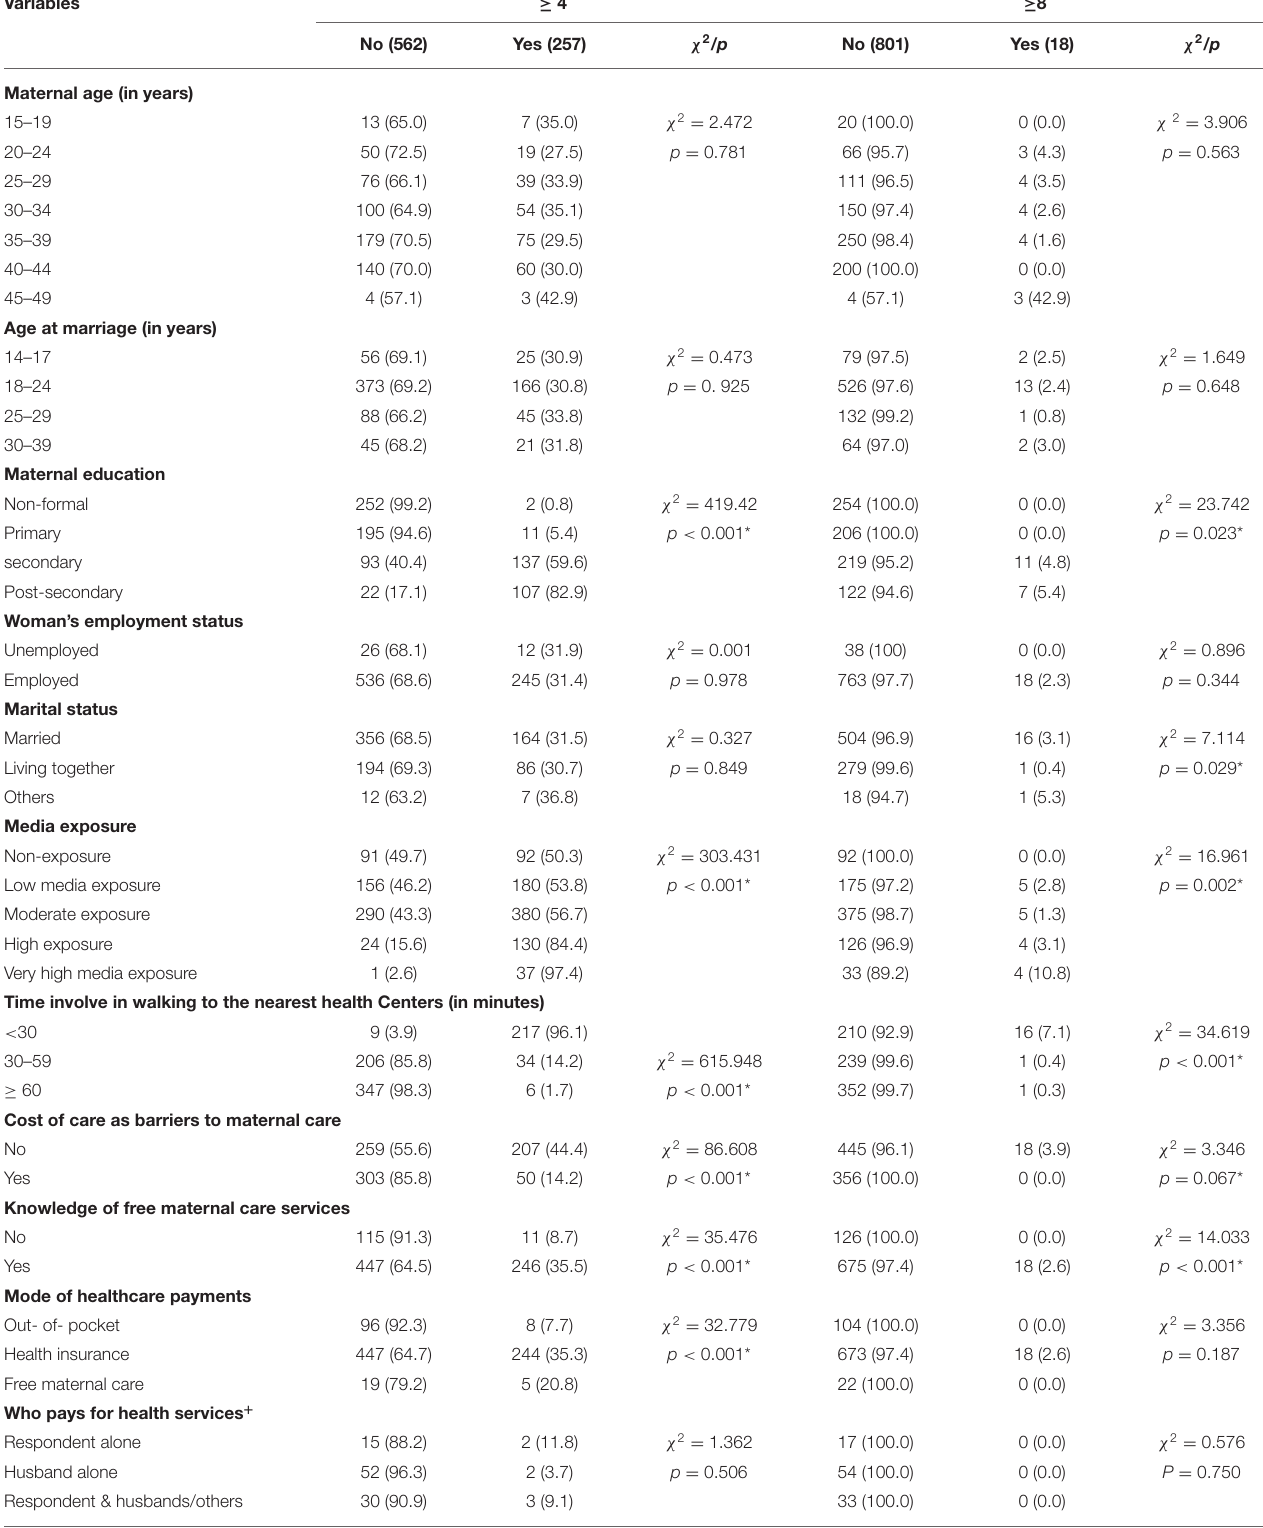
TABLE 2 | Factors associated with antenatal care contacts among the women in the household survey.